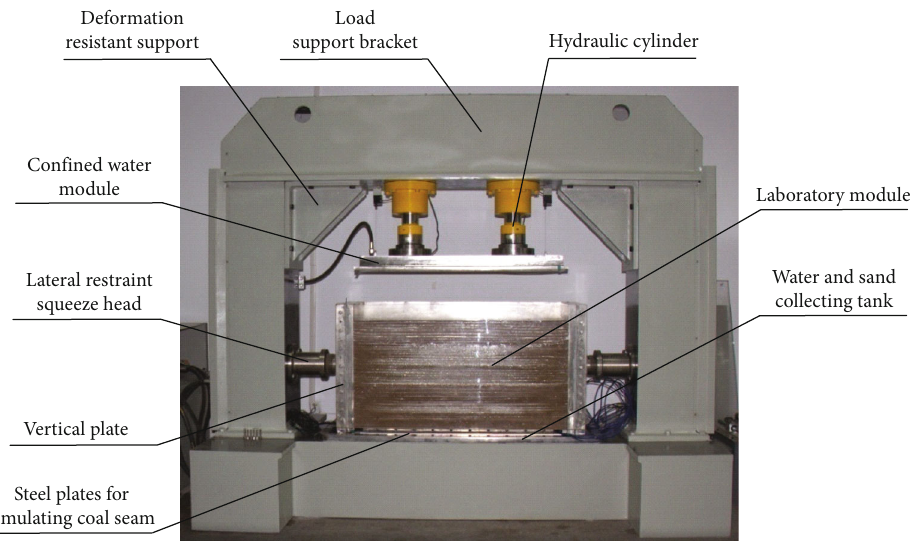
Figure 1: Structural diagrams of mechanical system.